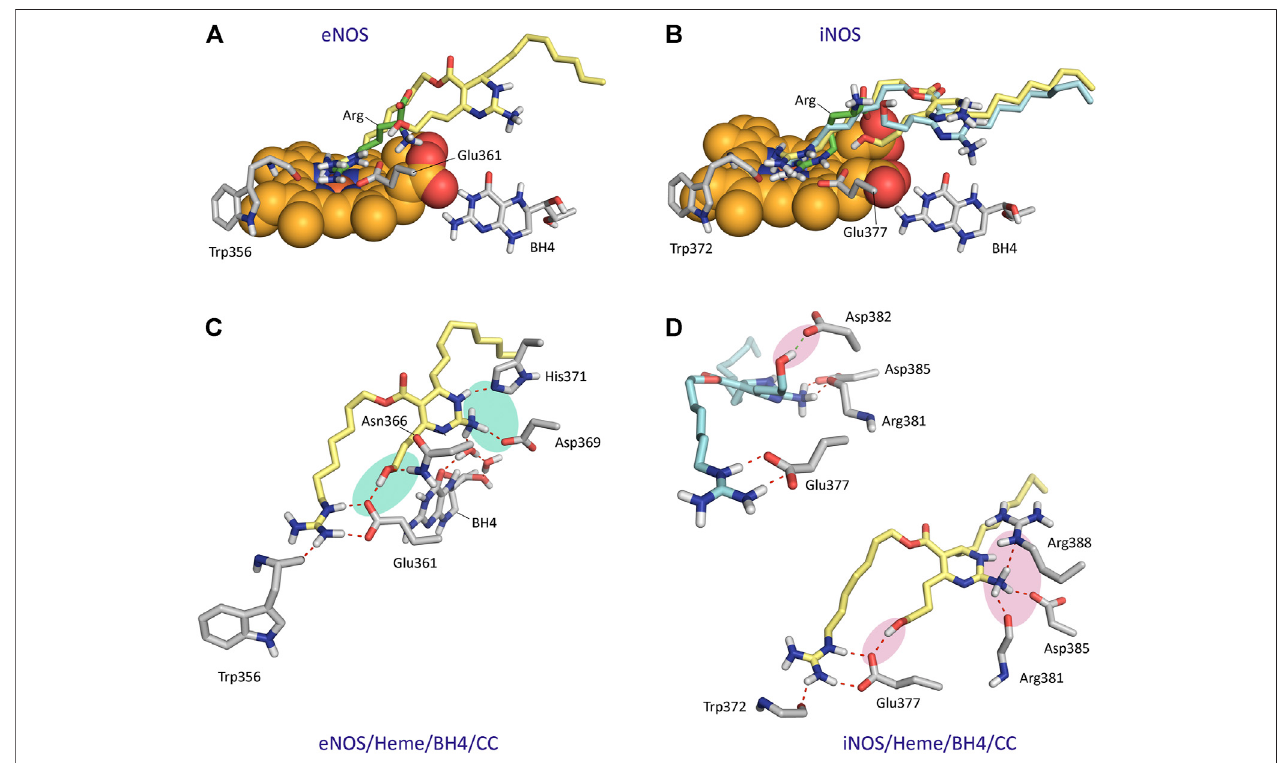
FIGURE6| BindingmodeofCrambescinC1(CC)intheactivesiteofNOSenzymesobtainedbydockingandMDsimulationstudies. (A) Comparisonofthebinding mode of CC (yellow) with the natural substrate (Arg, green) in the active site of eNOS. (B) Comparison of the two main poses of CC (yellow and blue) with the natural substrate in the active site of iNOS. The position of the heme group (spheres) and BH4 are shown (A,B) . (C) Interactions of CC with eNOS. Snapshot after 140 ns is shown. (D) Interactions of CC with iNOS. The major pose of CC is shown in yellow. Snapshots after 75 and 135 ns are shown. Relevant side chain residues are shown and labeled. Polar interactions between CC and the NOS enzymes are shown as red dashed lines. The most relevant polar interactions for panels (C,D) are highlighted with a shadow (blue and pink, respectively).